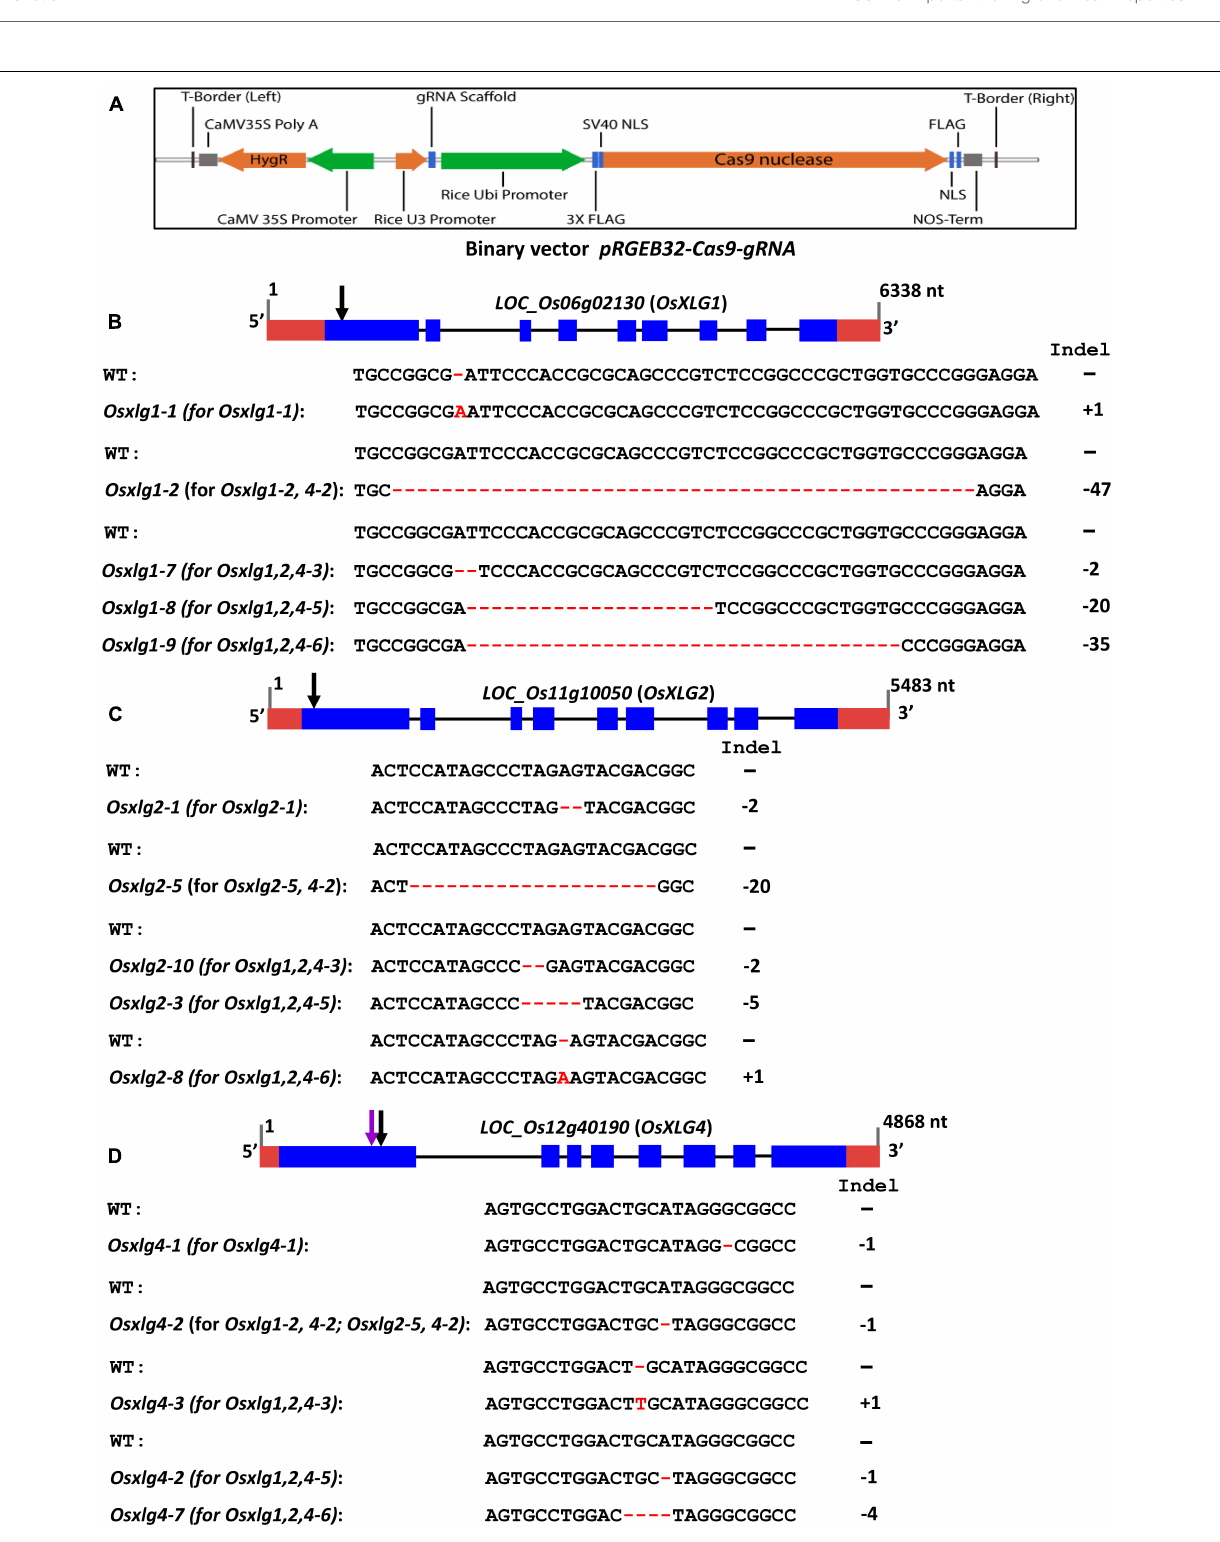
Frontiers in Plant Science |